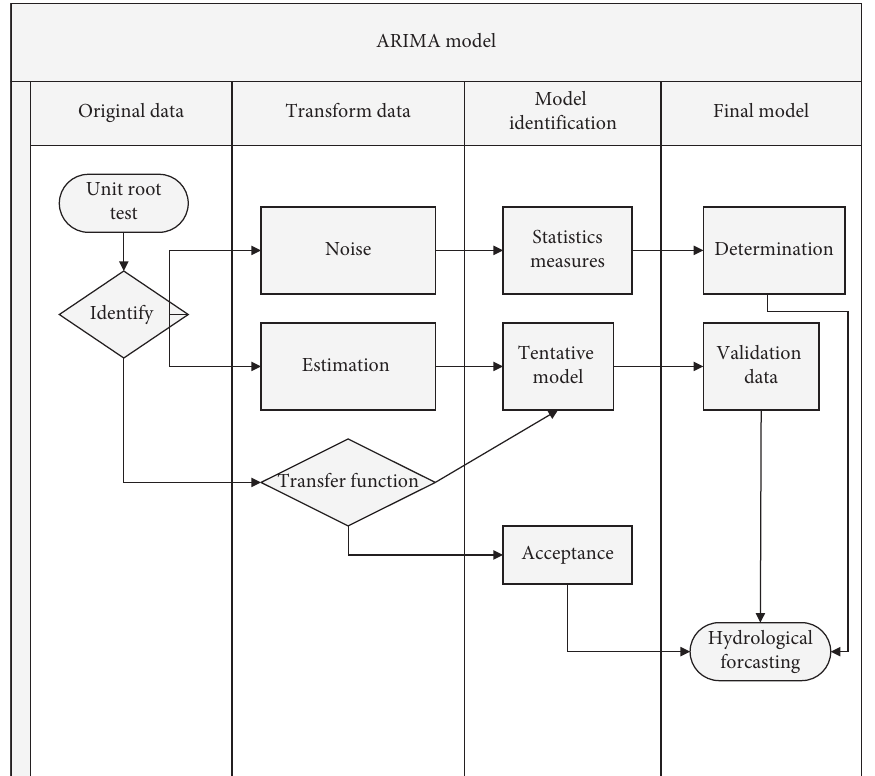
Figure 1: ARIMA modeling